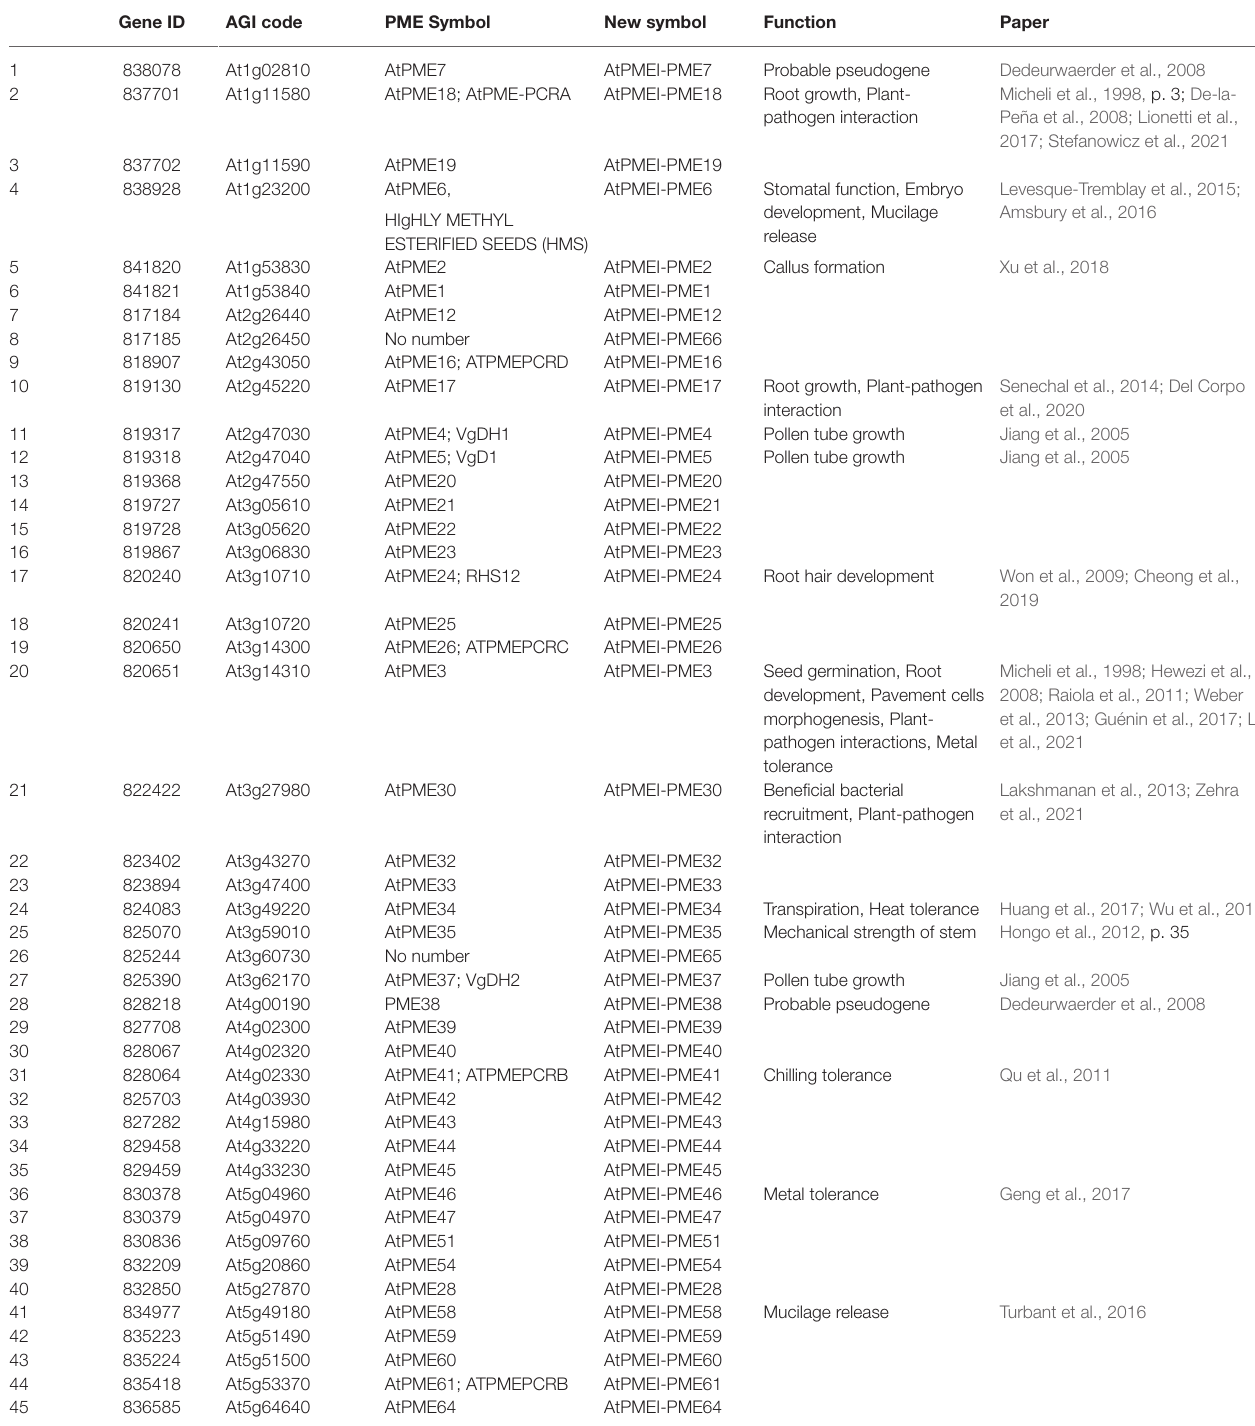
TABLE 3 | Arabidopsis INVI-PMEI protein isoforms clustered with a